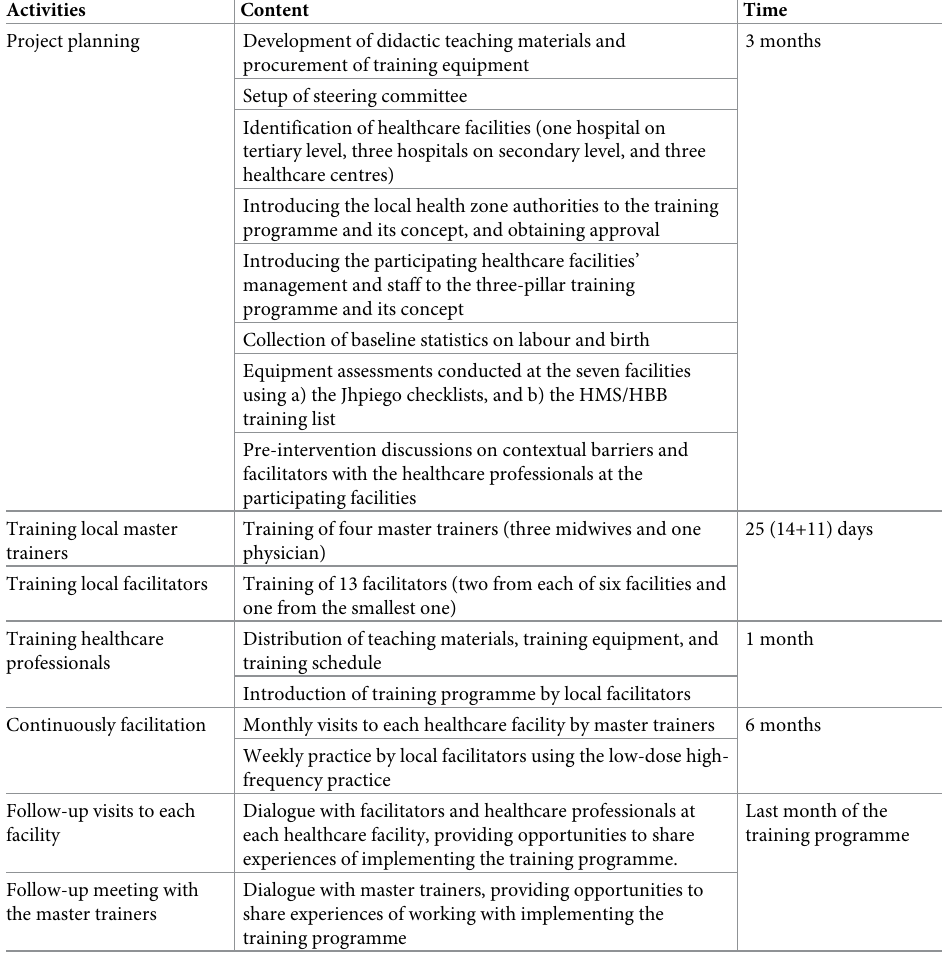
Table 2. Description of the implementation of the three-pillar training